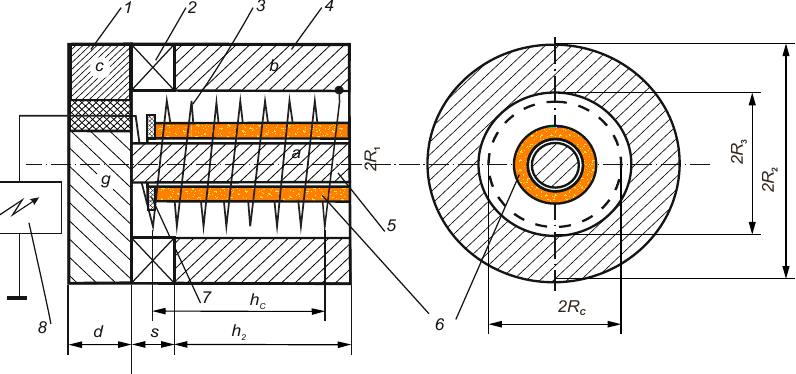
Figure 1. The accelerator schematic [10]: 1—disk-shaped magnetic circuit; 2—permanent magnet; 3—spiral electrode; 4—tubular magnetic circuit; 5—cylindrical magnetic circuit; 6—accelerated plasma flow; 7—dielectric washer; 8—current pulse generator.